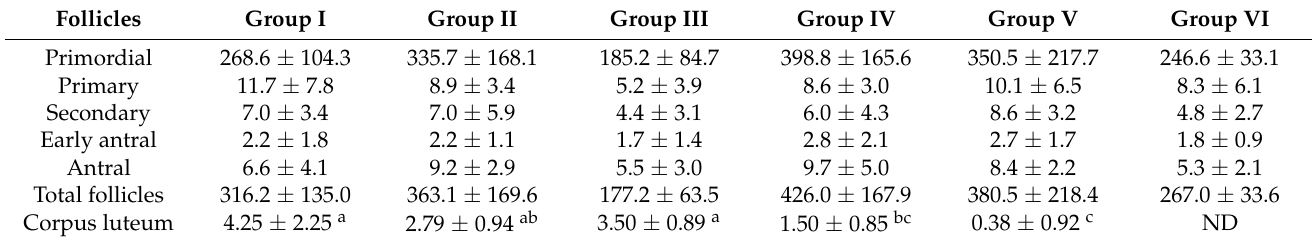
Table 1. Number of ovarian follicles and corpora lutea per group.